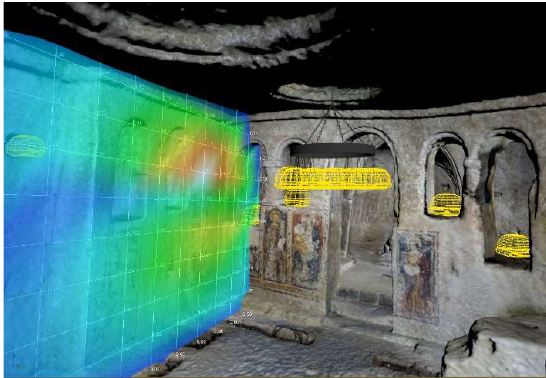
Figure 14: 3D Studio Max Sw. Lightmeter for lighting analysis. Natural and artificial lighting on the side wall.